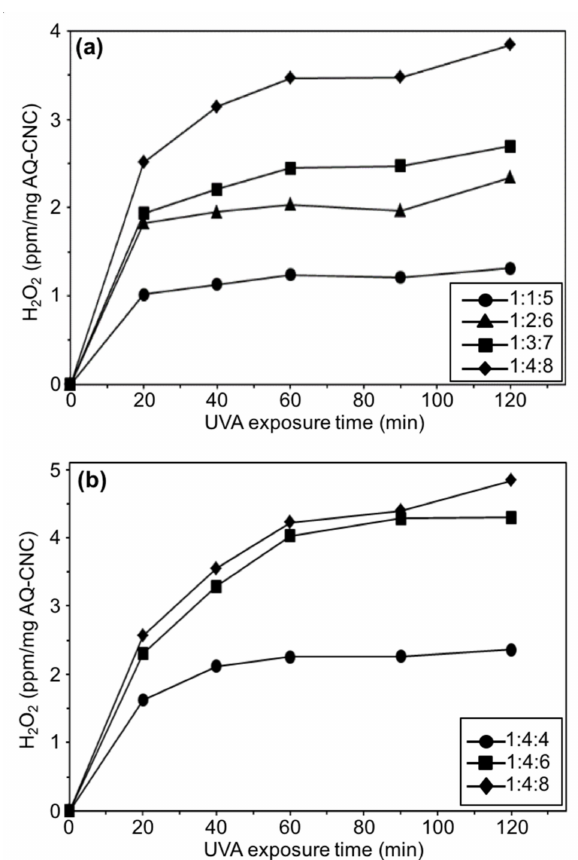
Figure 5. Amounts of hydrogen peroxide produced under UVA ( a ) by AQ-CNCs made from varied AGU / AQC molar ratios at a reaction time of 2 h and ( b ) by AQ-CNCs made from varied AQC / CDI molar ratios at a reaction time of 24